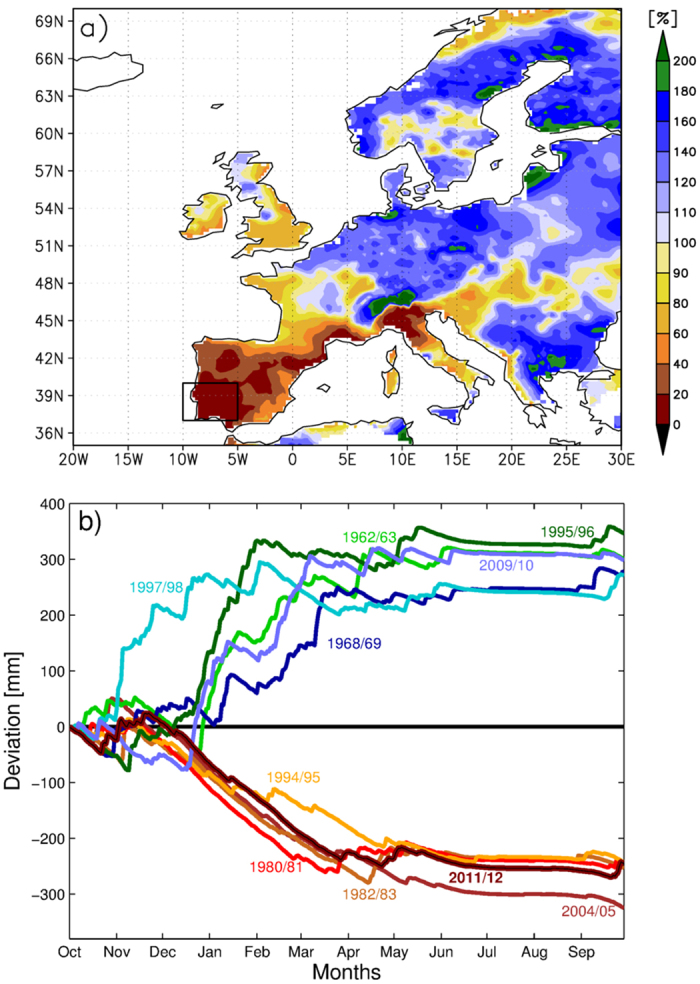
Precipitation anomalies during winter 2011/2012 over Europe, and cumulative precipitation anomalies for the five driest/wettest years for the southwest Iberian Peninsula since 1950.(a) Anomaly of winter (December 2011 to February 2012) relative to long-term mean for the period 1950-2013. 100% corresponds to long-term mean precipitation (565 mm); 20% corresponds to 20% of long-term mean precipitation during this period. (b) Accumulated precipitation deviations from climatology (1950–2013) during the hydrological year (1 October–30 September) for the area (10 °W–5 °W; 37 °N–40 °N) marked with a black box in (a). Only land grid points are considered.